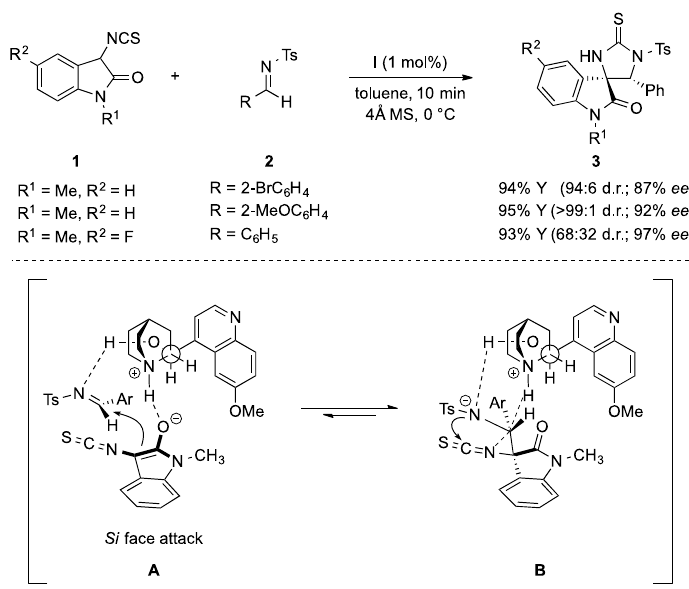
Scheme 1. Synthesis of spiro[imidazolidine-2-thione-4,3 ′ -oxindole] via domino Mannich/Cyclization